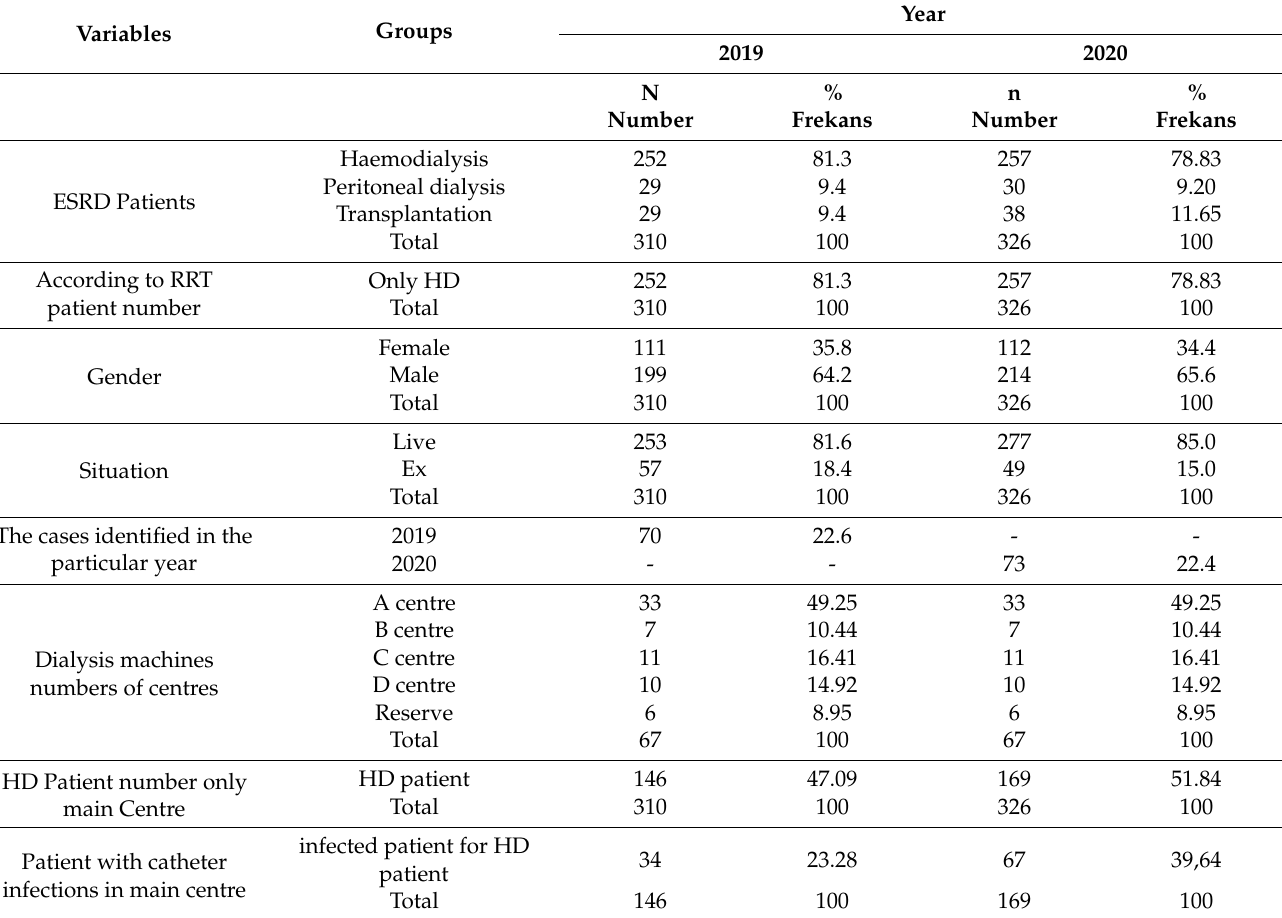
Table 1. CharacteristicinformationofEnd-StageRenalDiseasepatientsreceivingRenalReplacementTherapy.